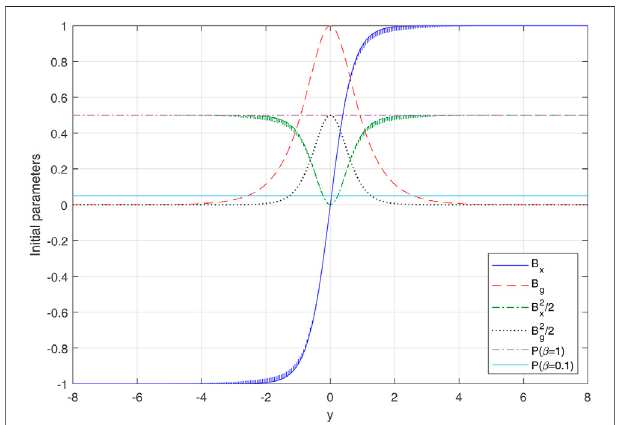
FIGURE 12 | Instability growth rate in presence of non-uniform guide fi eld.